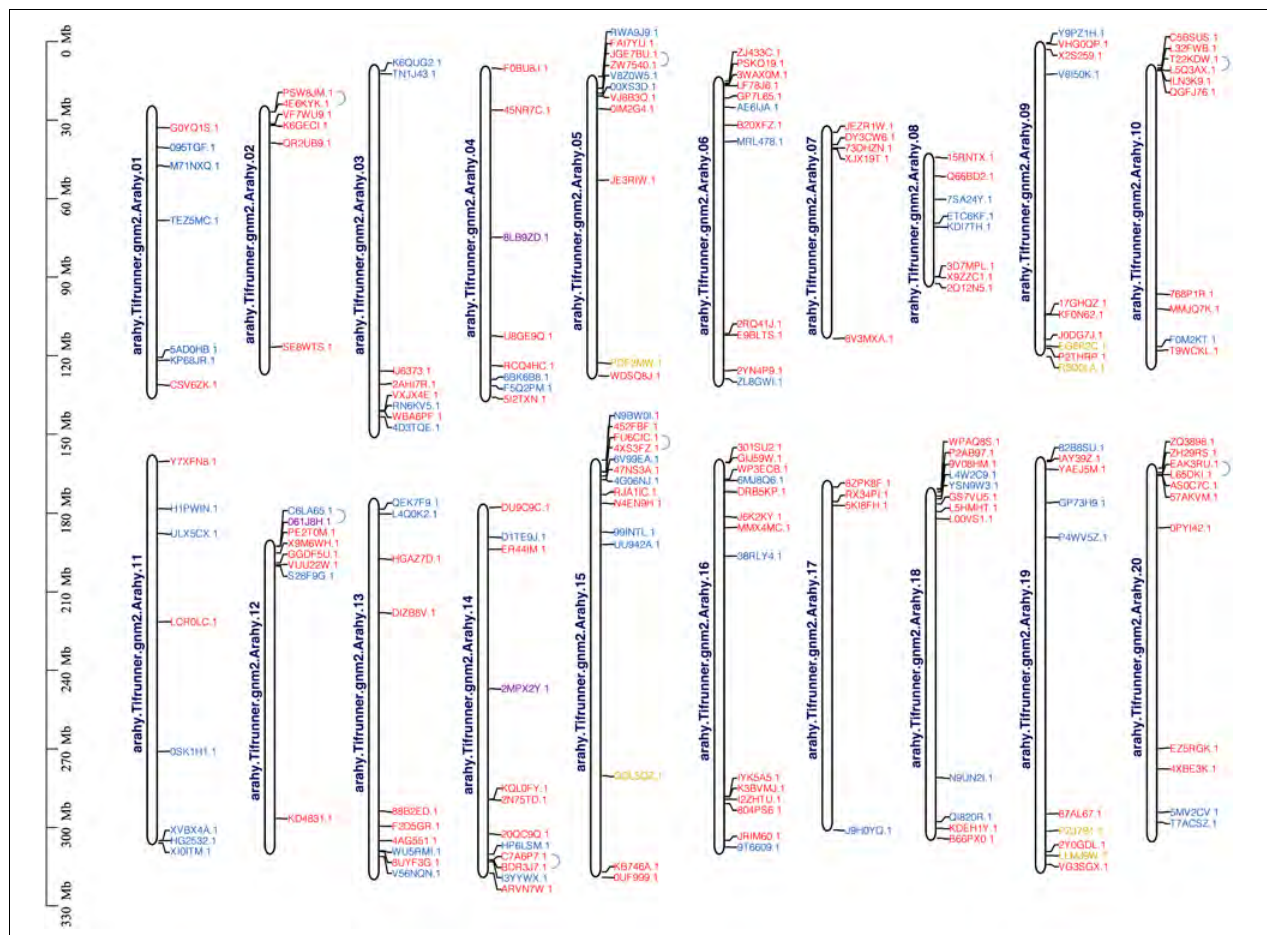
FIGURE 4 | Chromosomal distribution and tandem duplication of AhAP2/ERF s in A. hypogaea genome. Red gene ID: ERFs; blue gene ID: AP2; yellow gene ID: RAV; purple gene ID: